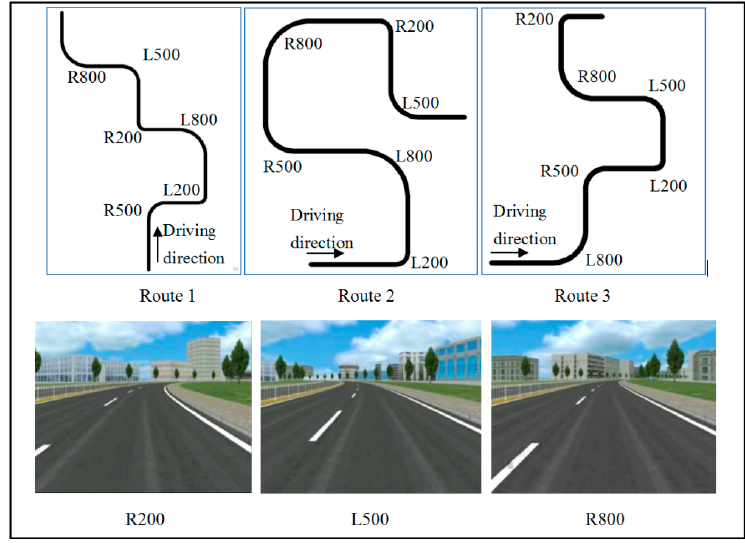
Figure 2. Three routes and simulated scenes.